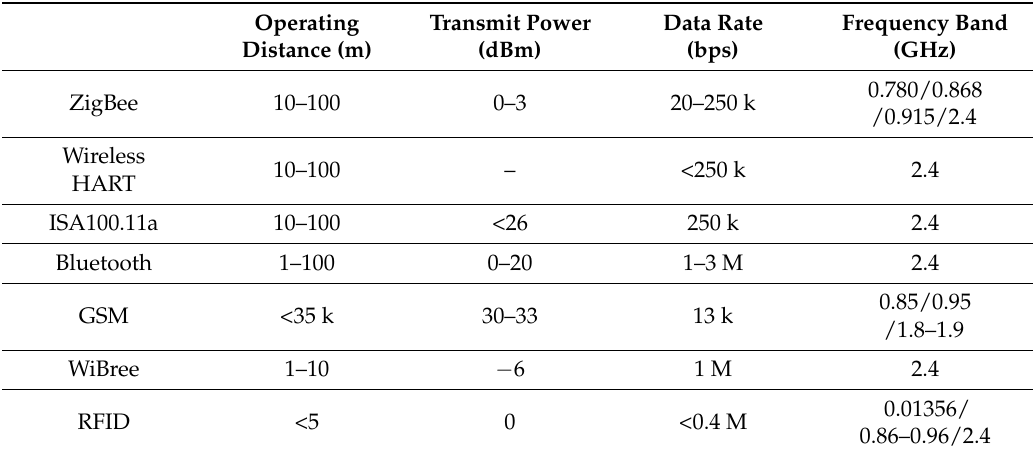
Table 1. Some typical protocols with their corresponding main characteristics.